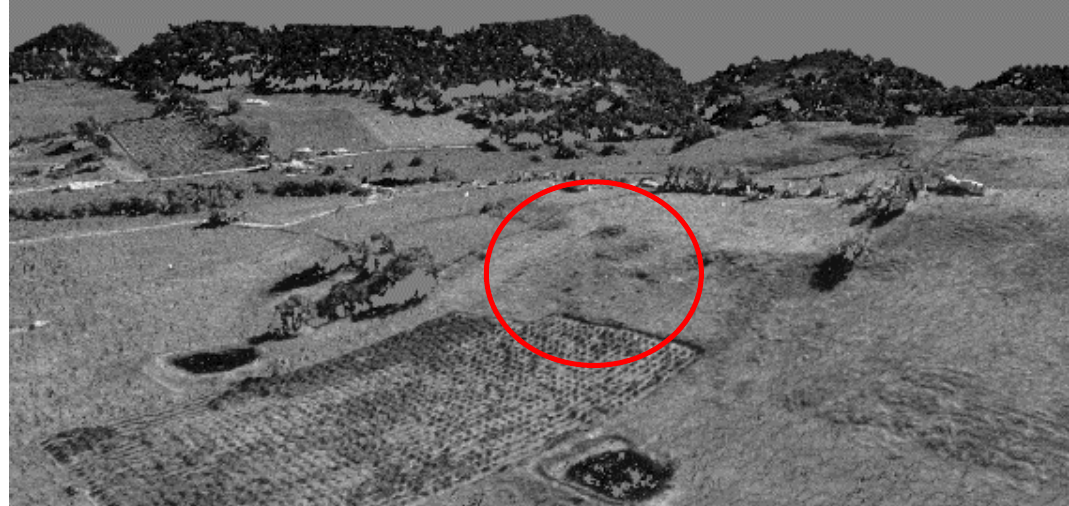
Figure 5. 3D model of the Home Hill landslide as constructed from 1984 aerial photography. The landslide area is circled in